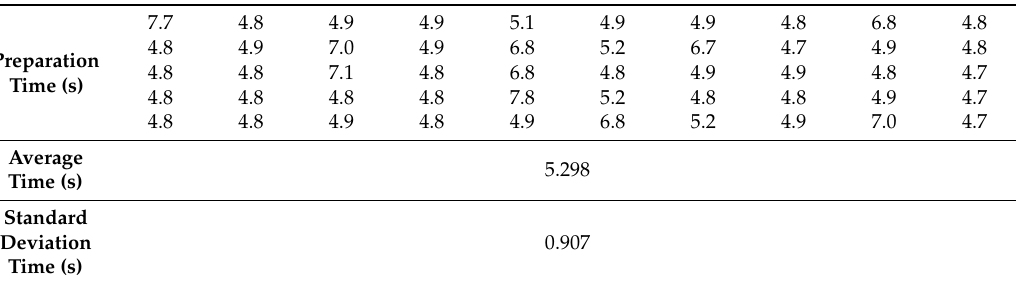
Table 1. Preparation time of CNC process.